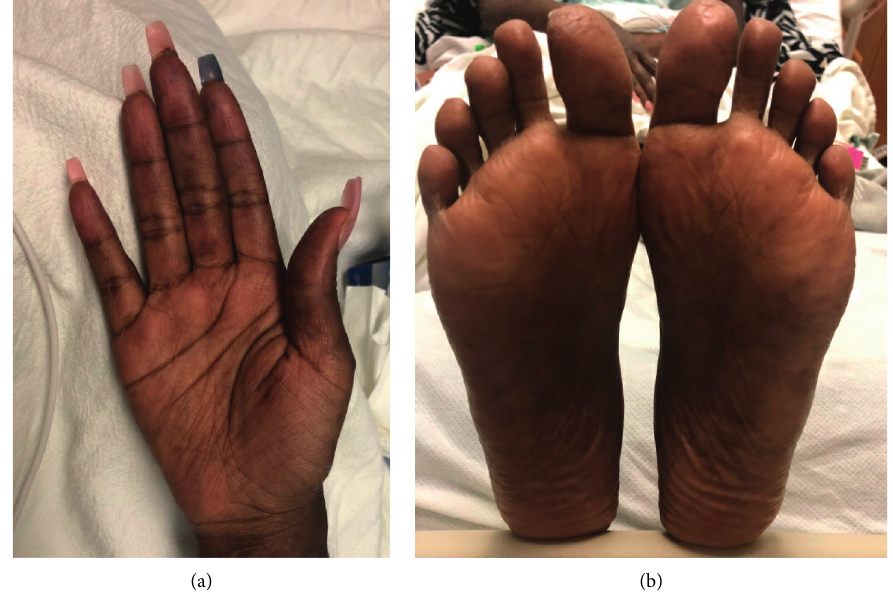
Figure 2: Complete resolution of lesions seen in Figure 1 approximately 3 months after treatment.